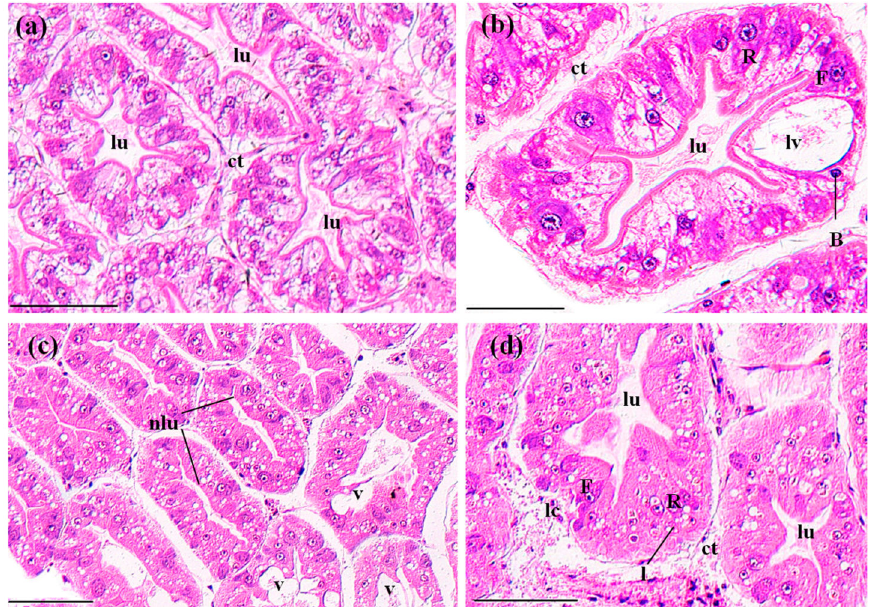
Figure 3. The tubules in perigastric organs of P. clarkii after 96 h exposure to: a control solution ( a , b ); and 72.62 mg/L MBA ( c , d ). ( a ) Control tubules with normal structures and intertubular connective tissue (ct) (200 × ). ( b ) Control tubules showed different cell types, including B-cell (B), F-cell (F) and R-cell (R). Note the large vacuole (lv) which occupies most of the B-cell (400 × ). ( c ) Damaged tubules exhibited narrowing of the lumina (nlu) and vacuolation (v) in some cells (200 × ). ( d ) Damaged tubules exhibited slight cellular destruction and lysis of the cytoplasm (lc) in some cells (400 × ). Note the decrease of the lipid granules in ( c , d ). lu, lumen; ct, connective tissue; B, B-cell; F, F-cell; R, R-cell; l, lipid granules. H&E stain, scale bars = 100 µ